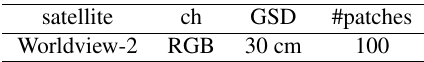
Table 2. Experimental Dataset. These images have 30 cm GSD and were collected with the WorldView-2 sensor from